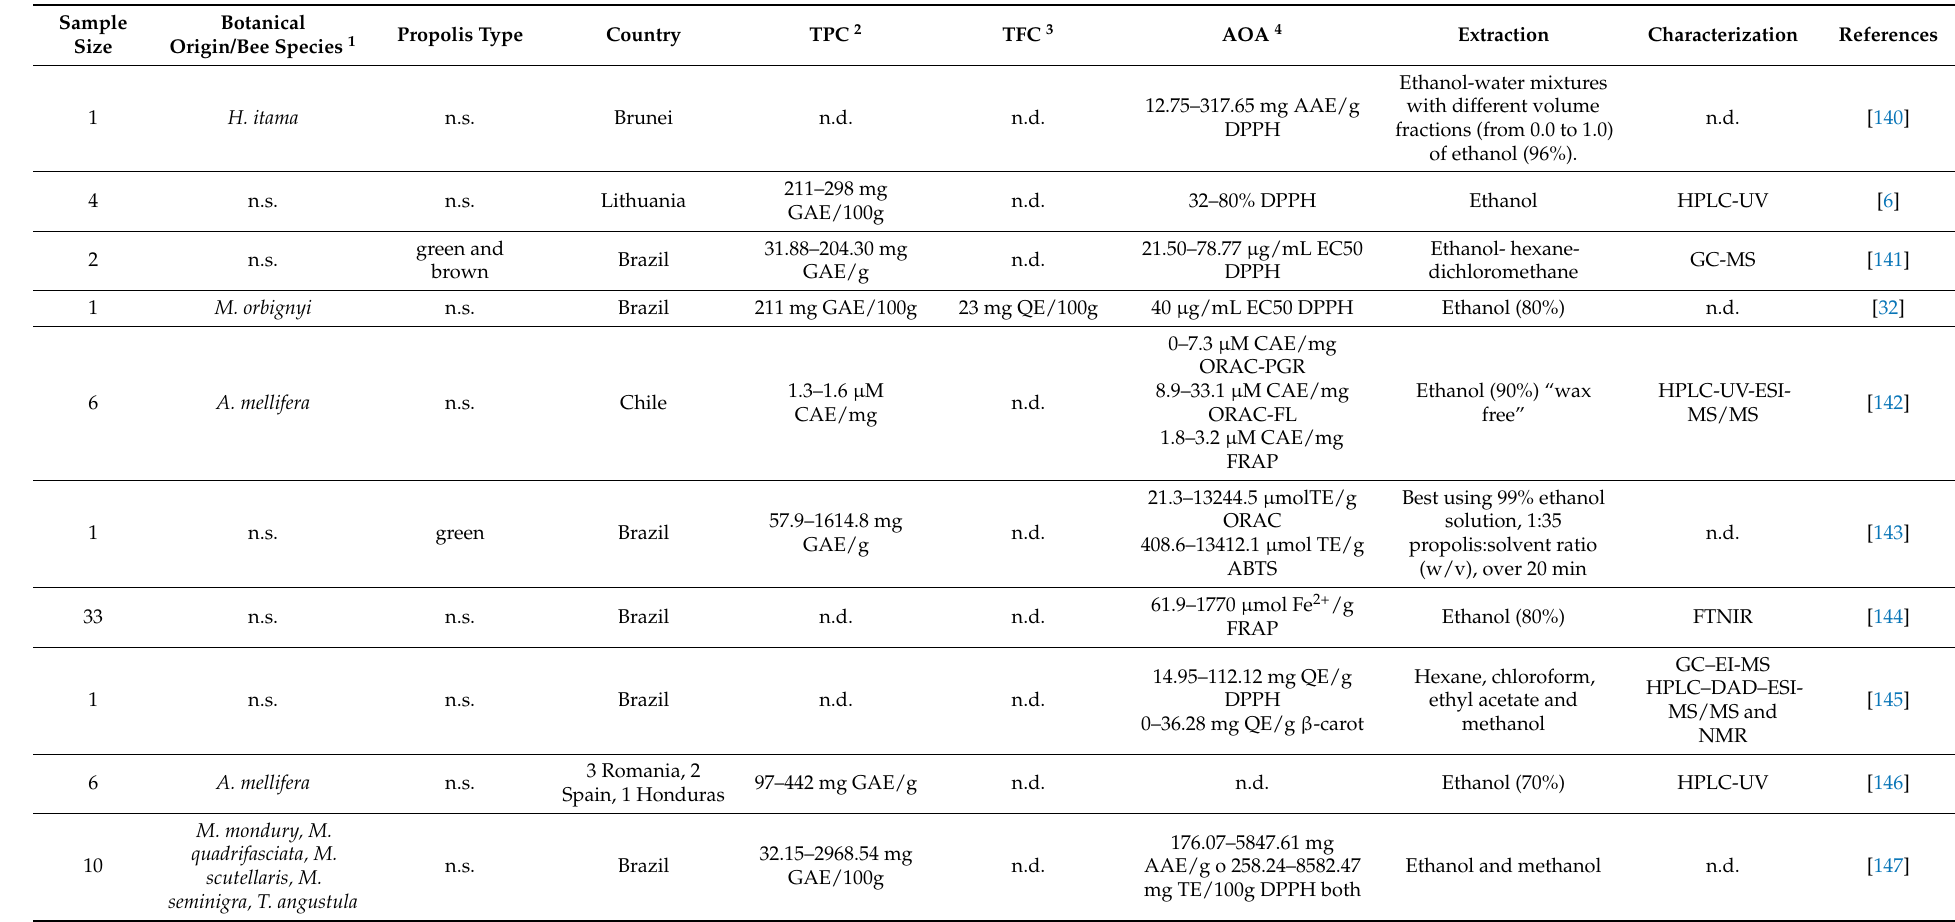
Table 4. Summary of the results from studies on antioxidant capacity in